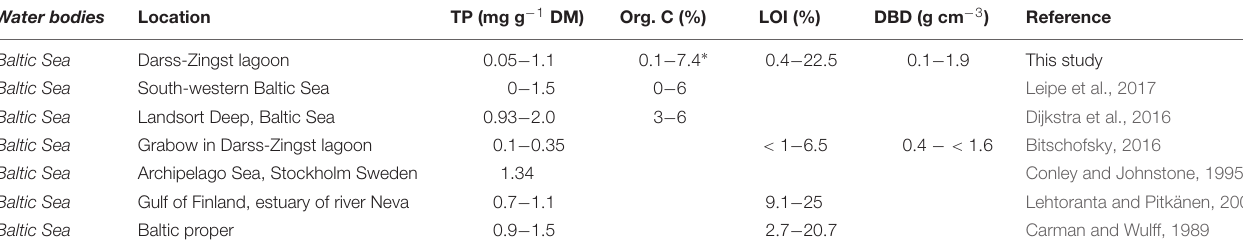
TABLE 2 | Overview of commonly found sediment parameter in combination with total phosphorus (TP) concentrations.